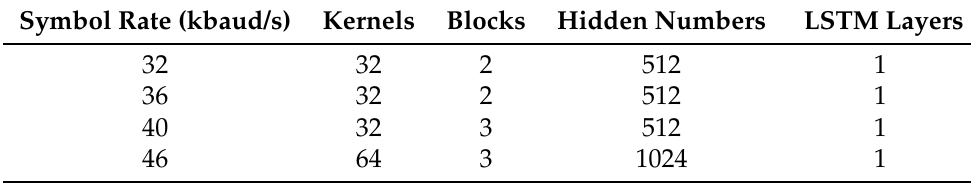
Table 1. Optimal parameters in compromising consideration.